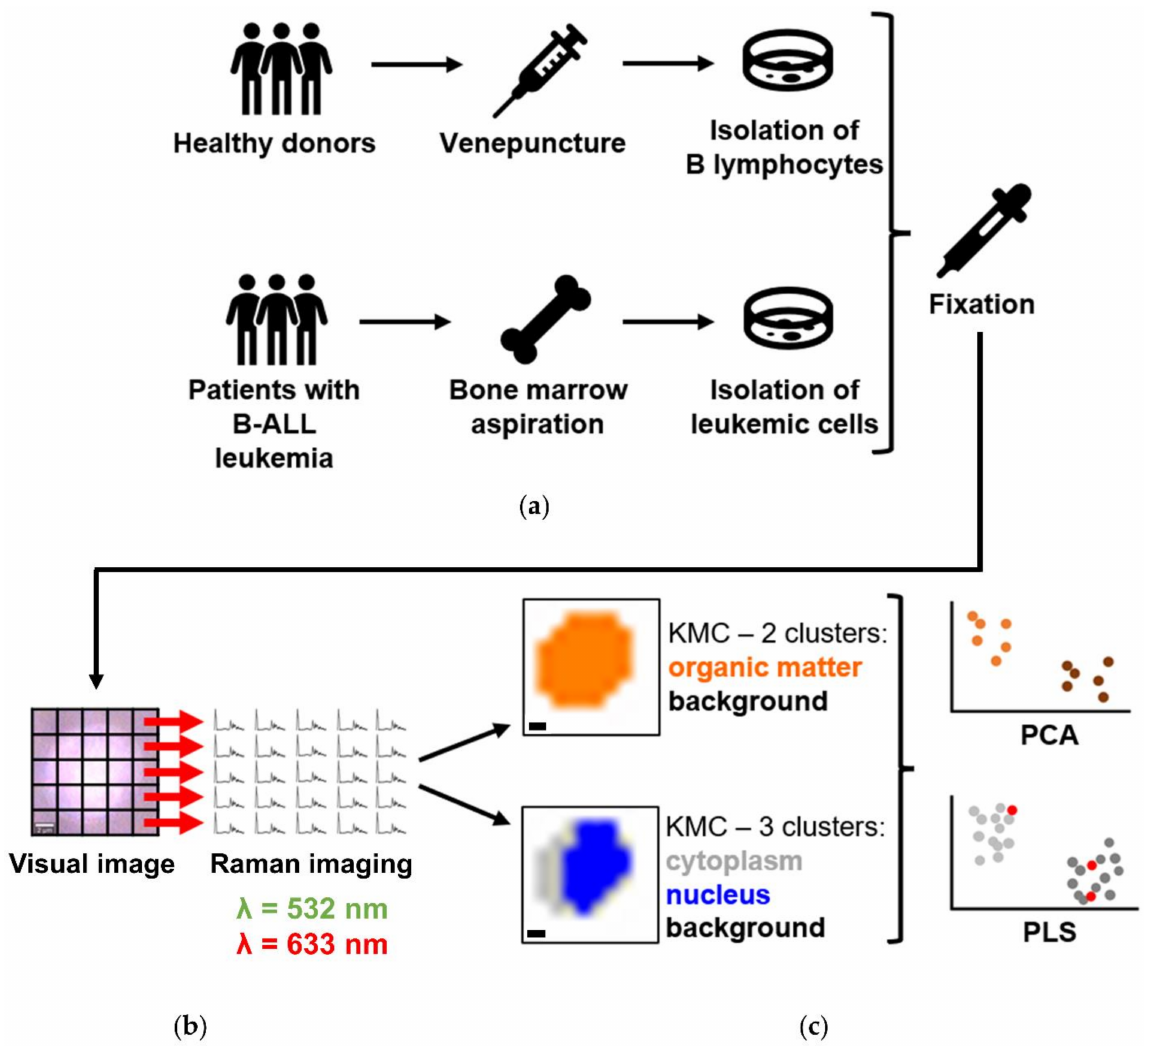
Figure 1. Scheme of conducted experiments. ( a ) Blood samples were drawn from healthy donors via venipuncture, and B cells were isolated. Leukemic cells were isolated from the bone marrow aspirate on the day of diagnosis of BCP-ALL and deposited in the Bio-Bank from patients with B-ALL. All cells were fixed with 0.5% GA and became a subject of ( b ) Raman imaging with two laser excitation wavelengths: 532 nm and 633 nm. Scale bar: 1 µ m. ( c ) Subsequently, the acquired spectra were grouped using KMCA considering two approaches: deriving two clusters—organic matter and background, and 3 clusters—cytoplasm, nucleus, and background. After that, three groups of spectra were analyzed using PCA and